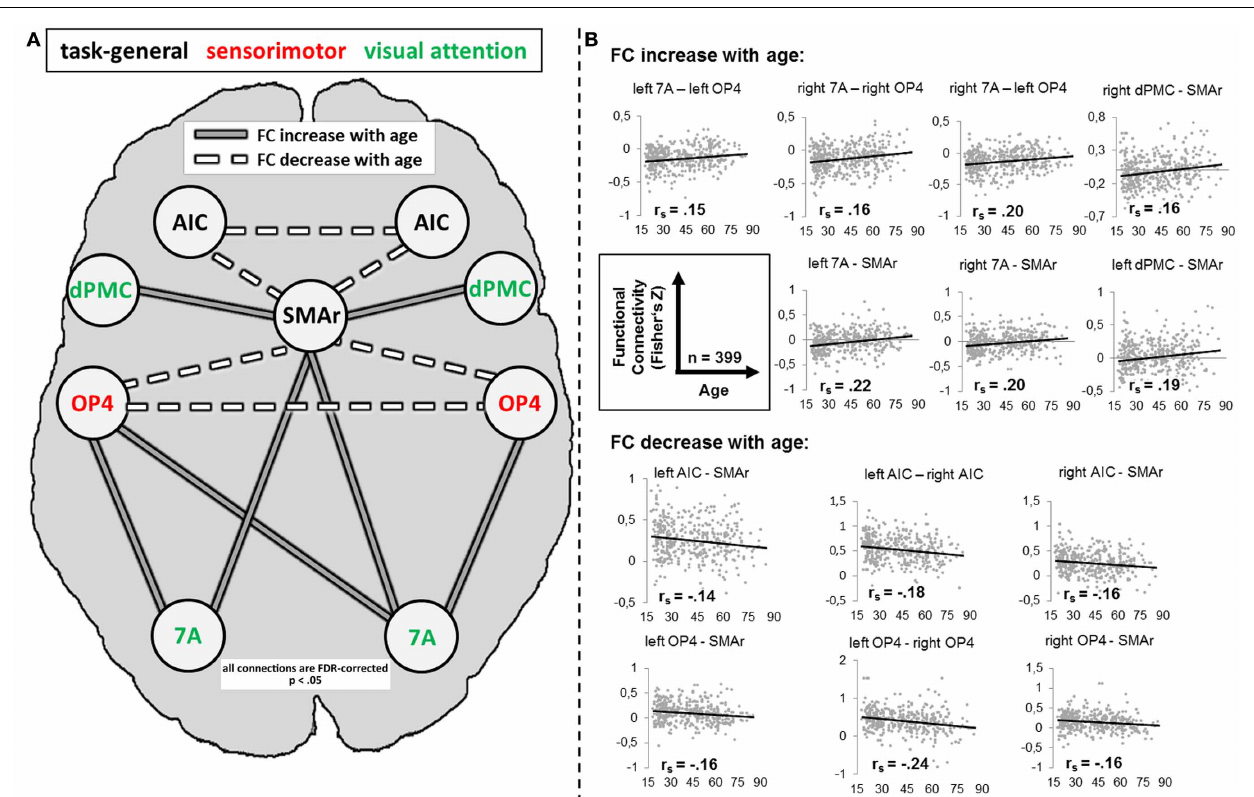
FIGURE 5 | (A) Alteration of resting-state functional connectivity (FC) with age (schematic). White lines reflect significant positive resting-state FC between regions (independent of age); gray lines reflect significant negative resting-state FC between regions (independent of age). Dotted lines reflect a significant decrease [ p < 0 . 05, corrected for multiple comparisons using the false discovery rate (FDR)] of FC with age; solid lines reflect a significant increase ( p < 0 . 05, FDR-corrected) of FC with